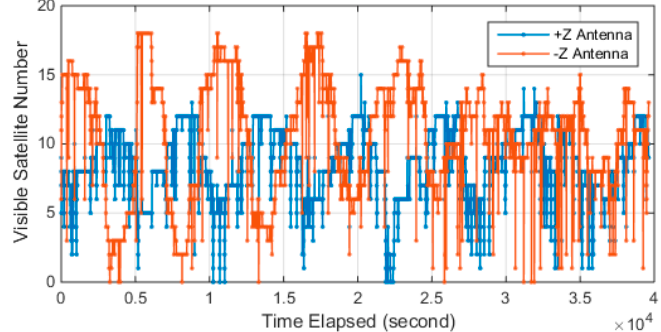
Figure 5. Visible satellite number of different +Z and –Z GNSS antennas.